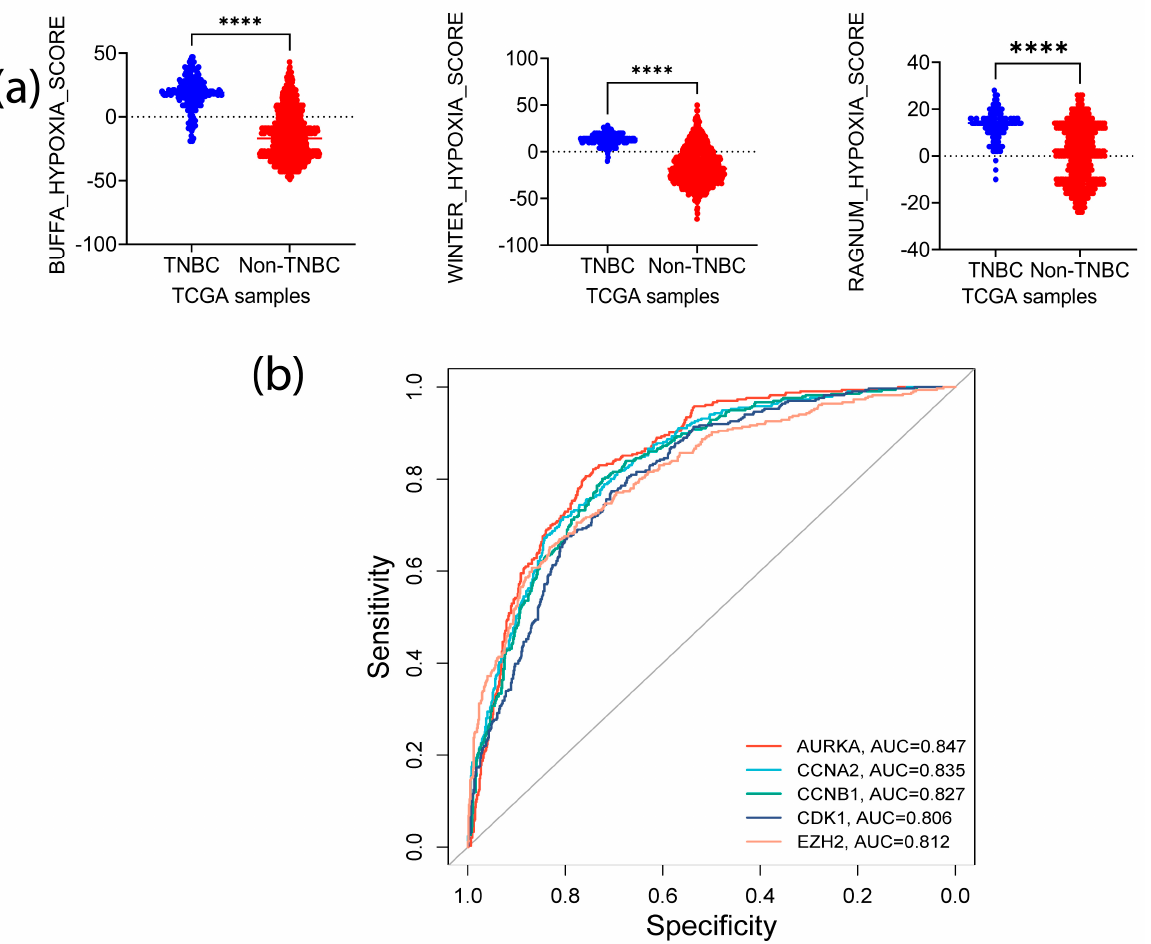
Figure 6. Correlation of the SGs with tumor hypoxic status. ( a ) Hypoxia intensity of TNBC vs. other types of BCs ( p ≤ 0.0001—****); ( b ) ROC analysis to evaluate the potential of the SGs in the prediction of tumor hypoxia status in TNBC.